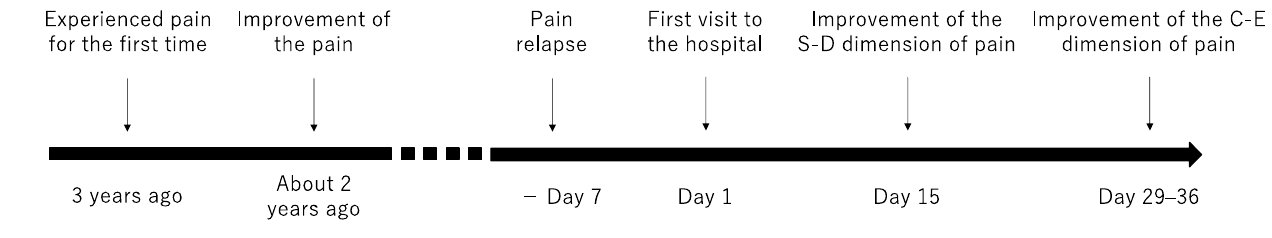
Table 1. Maximum widths and areas in the portrait